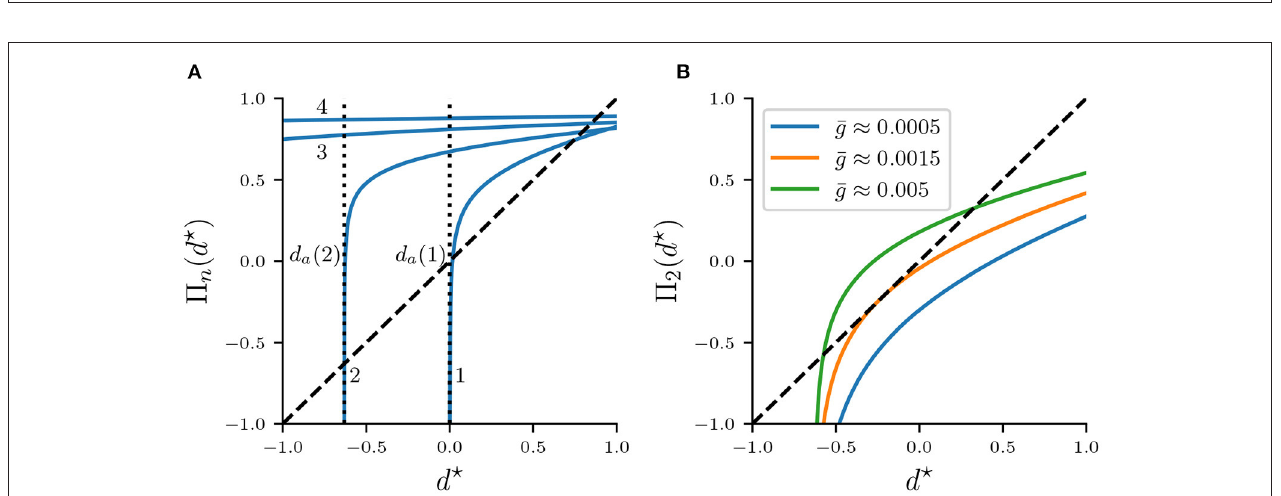
FIGURE 8 | Map 5 n : d ⋆ 7→ d ⋆ . (A) 5 n for n = 1,2,3,4 at ¯ g = 0.5 mS / cm 2 . (B) 5 2 with n = 2 for various ¯ g . The identity function is illustrated by a diagonal line.